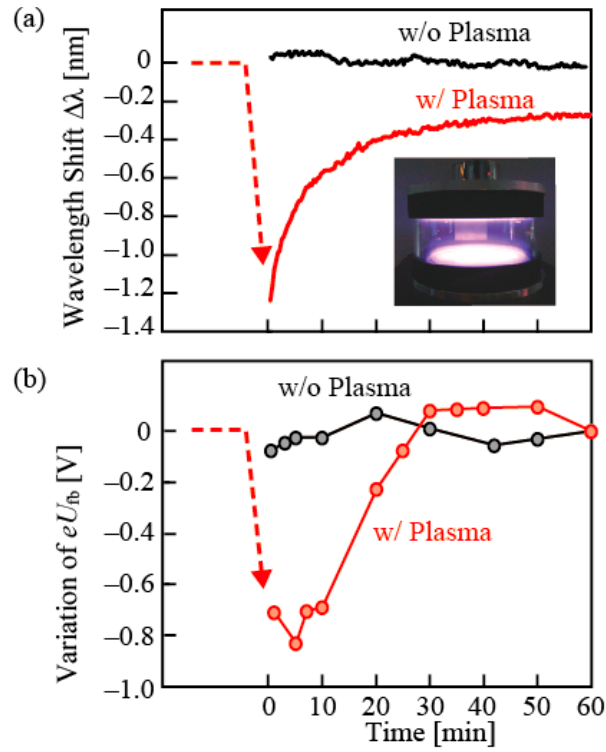
Figure 12. Response of GaInAsP nanolaser after plasma exposure. ( a ) Wavelength shift. The inset shows the appearance of the plasma exposure. ( b ) Flat band potential.